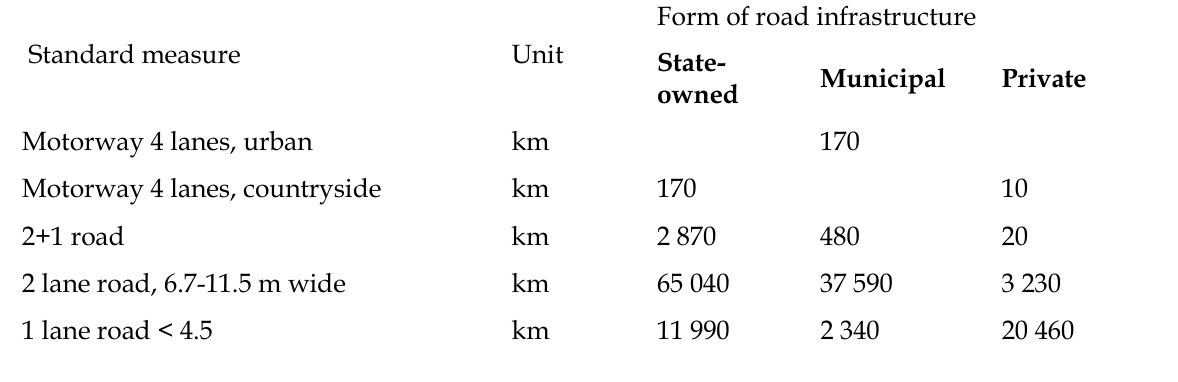
Table A5. Operation and maintenance of road infrastructure: the infrastructure stock divided into standard measures representative of the standard measures in Klimatkalkyl to calculate impacts of maintenance and operation. Because Klimatkalkyl uses another approach to calculate impacts of operation and maintenance than impacts of construction and reinvestment, other standard measures are accounted for in Table